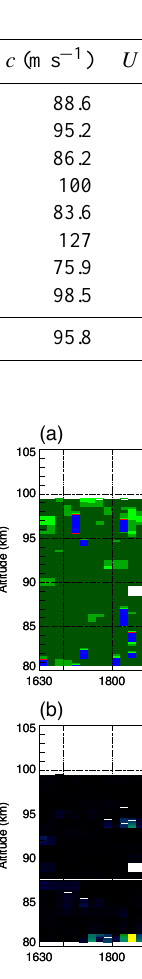
Figure 7. (a) Variations of the Richardson number from 81 to 99km between 16:30 and 24:30UT on 29 October 2010. Negative values are shown by blue filled squares. (b) Error values of the Richardson